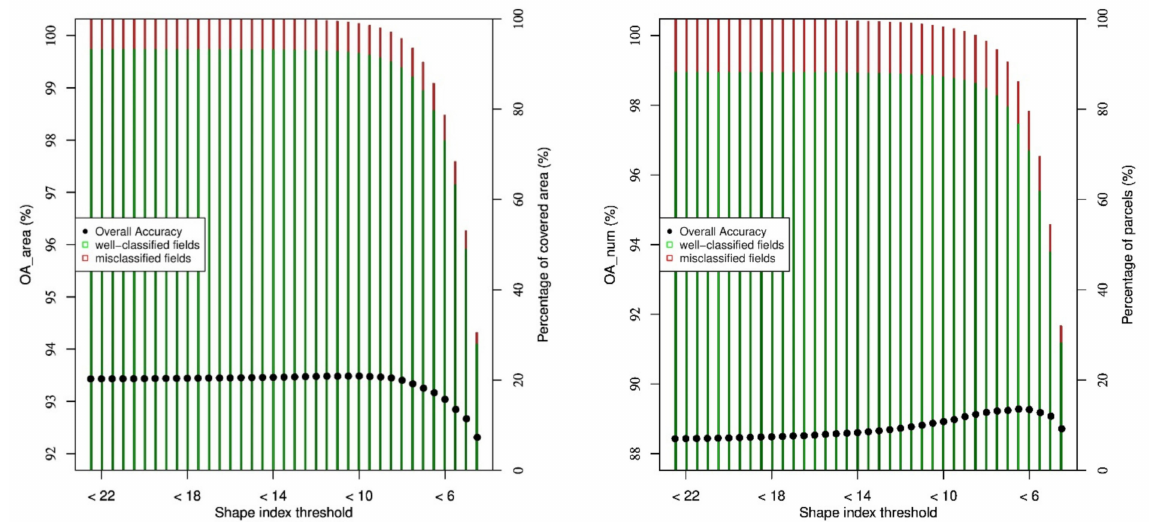
Figure 6. Evolution of the overall accuracy considering a threshold on the shape index. ( Left ): OA in terms of the area. ( Right ): OA in terms of the number of